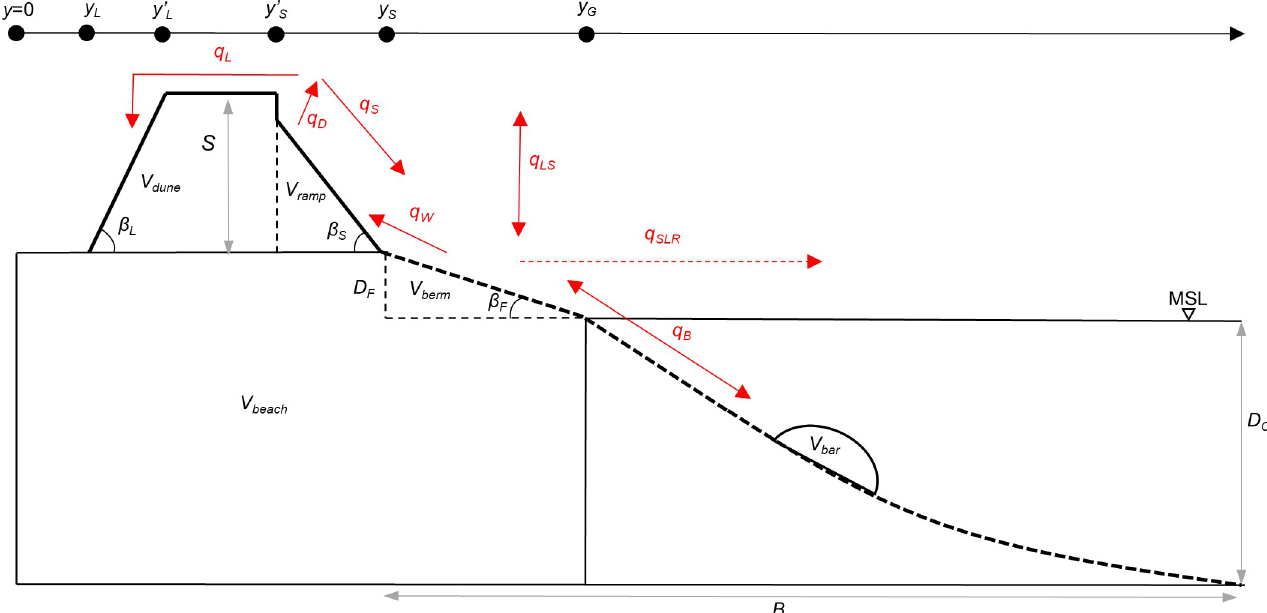
Fig 3. Definition of heights, length coordinates, volumes and transports (red arrows).